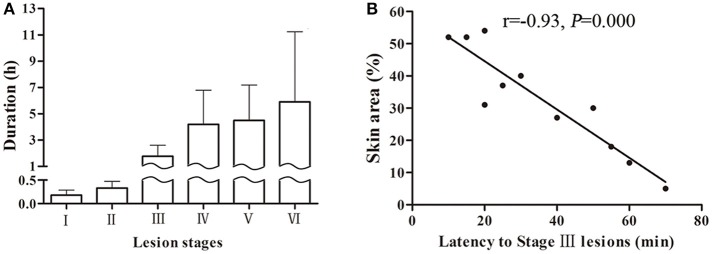
Skin lesion durations of each stage in a swine DCS model. Eleven swine following a simulated air dive to 40 m for 35 min with 11 min decompression. A total 44 lesions were observed. Durations of each stage are shown (A). The correlation between skin area and latency to Stage III lesions are shown (B).